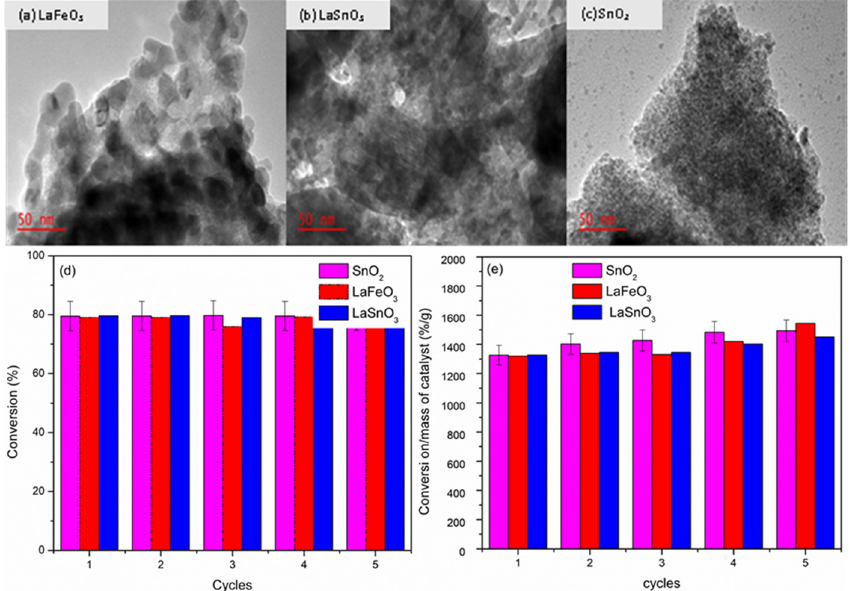
Figure 7. TEM image of the spent ( a ) LaFeO 3 ; ( b ) LaSnO 3 ; ( c ) SnO 2 ; ( d ) percentage conversions per cycle; and ( e ) normalised conversions. cycle; and ( e ) normalised